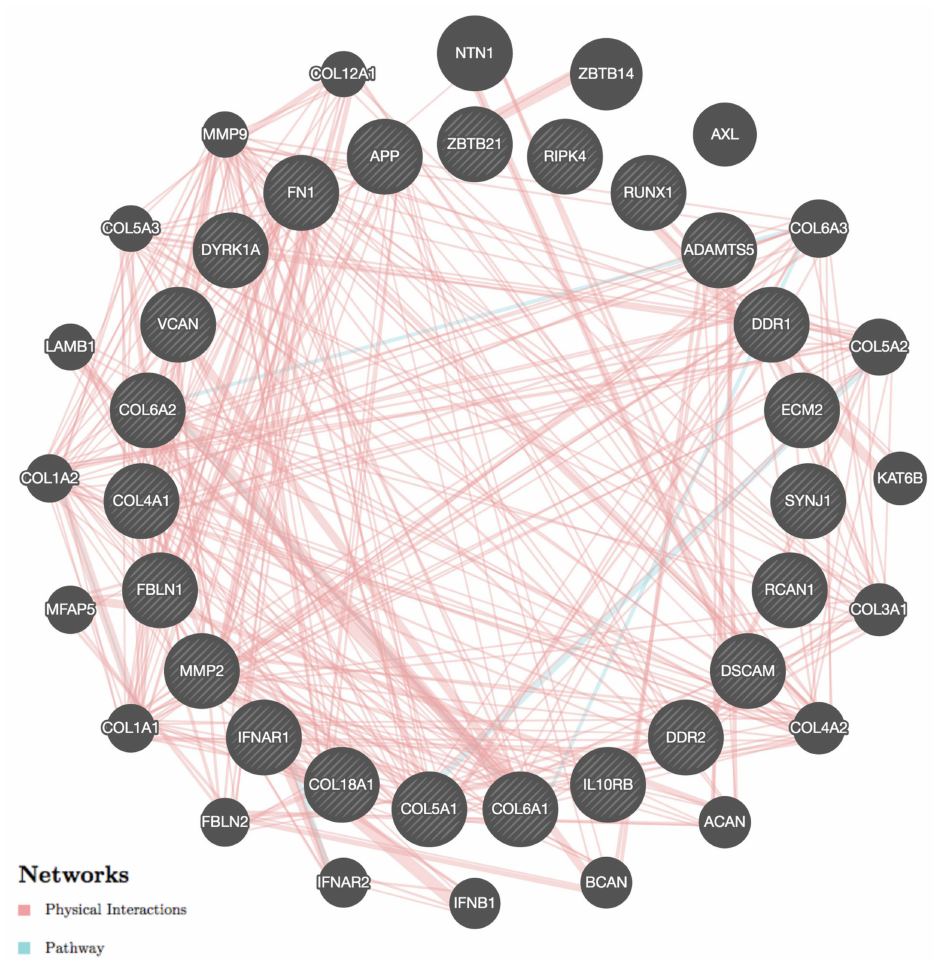
Figure 2. Interactions among genes involved in CHD. The figure illustrates the physical interactions and participation in the same pathway of genes involved in CHD generation, obtained using the GeneMANIA software (version 3.6.0) [174,175] (available at: https://genemania.org/ (accessed on 27 January 2023)). The genes discussed in this review are represented by the striped circles depicted in the inner ring. They are connected to each other by lines of different colors, each indicating a specific type of interaction: pink for physical interactions and light blue for pathways. The outer ring shows genes closely related to those in the inner ring (according to the GeneMANIA software). These genes are represented as circles of different sizes according to their ranking, which is achieved by scoring them using label propagation. By inputting the names of the genes in GeneMANIA, it is possible to generate an image featuring active links that provide additional information about all interactions and relevant literature